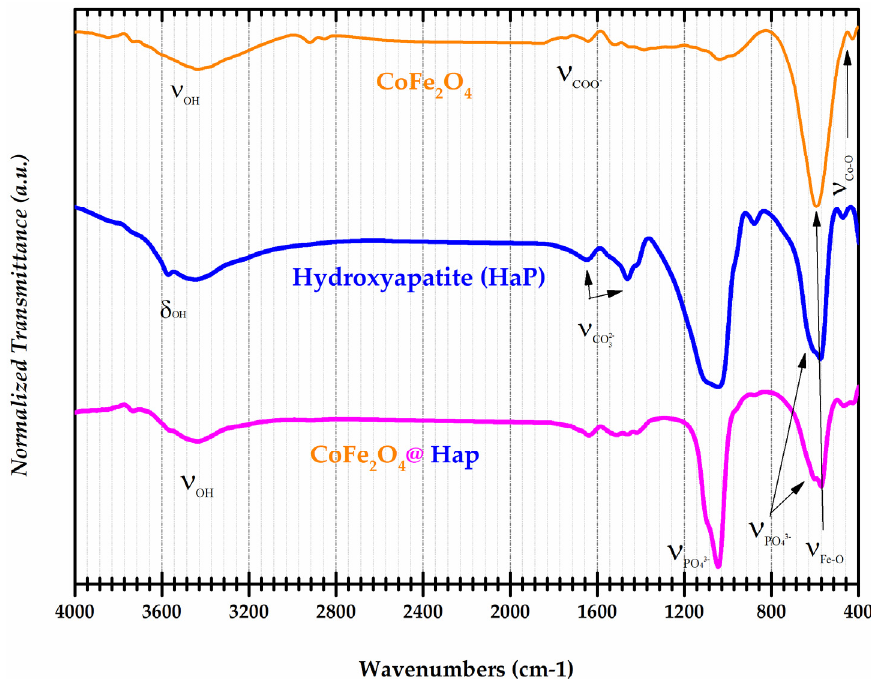
Figure 4. Normalized FT-IR spectra of CoFe 2 O 4 , Hydroxyapatite (HaP), and CoFe 2 O 4 @HaP sam-